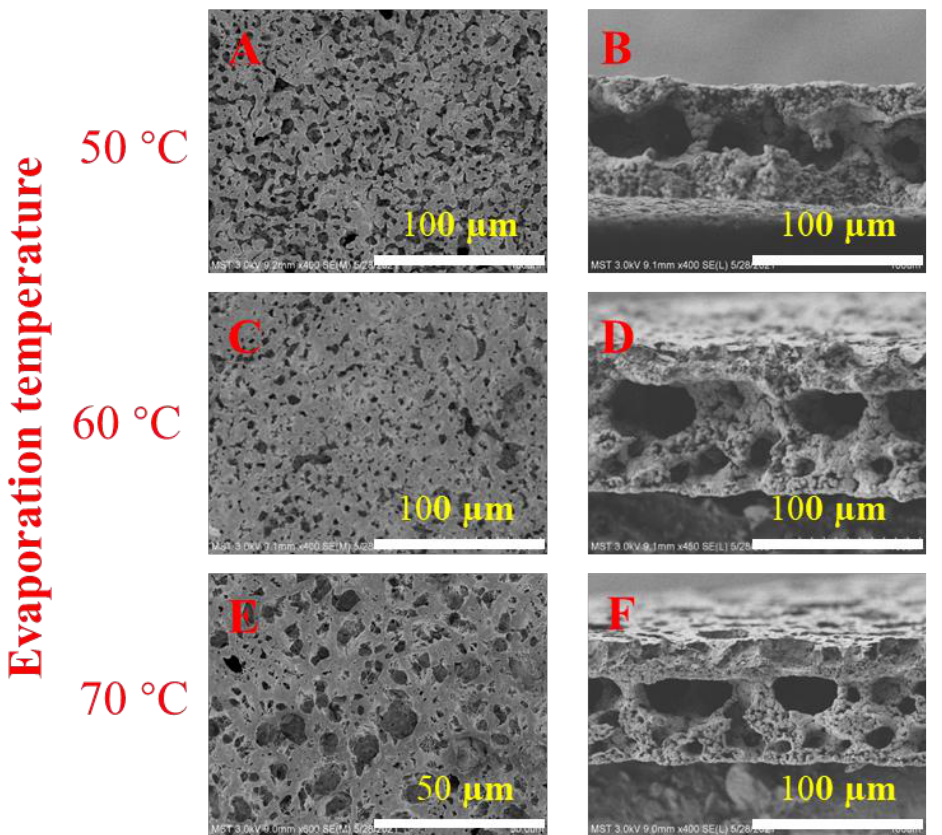
Figure 6. SEM images of PVDF membranes prepared at different vapor temperatures. ( A , B ) 50 °C ; ( C , D ) 60 °C and ( E , F ) 70 °C .